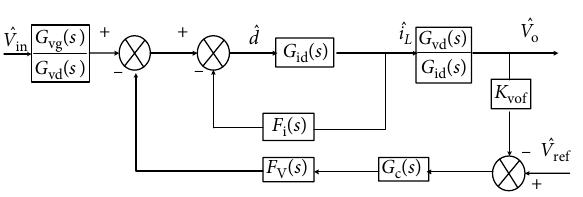
Figure 3: Duty cycle change caused by primary current disturbance.